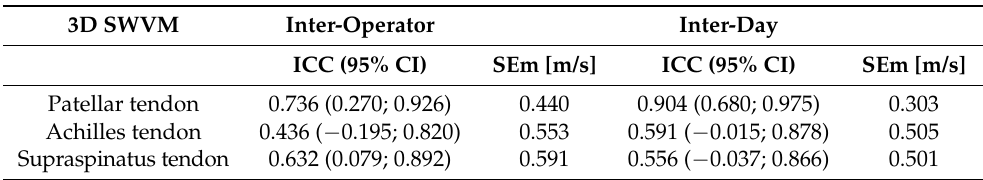
Table 2. Estimates of intra-class correlation coefficients (ICC) and standard error of measurement (SEm) for the assessment of the patellar, Achilles, and supraspinatus tendons using 3D shear wave velocity mapping.